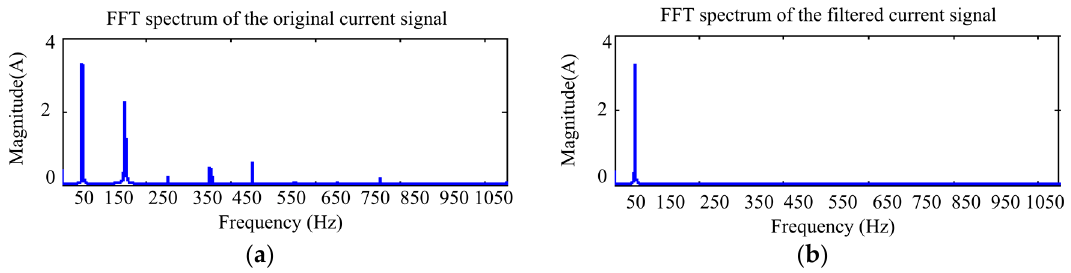
Figure 12. Secondary board SB3.1.1 FFT spectrum at a time when severe stationary disturbances are present: ( a ) original current signal; and ( b ) filtered current signal around the fundamental frequency.